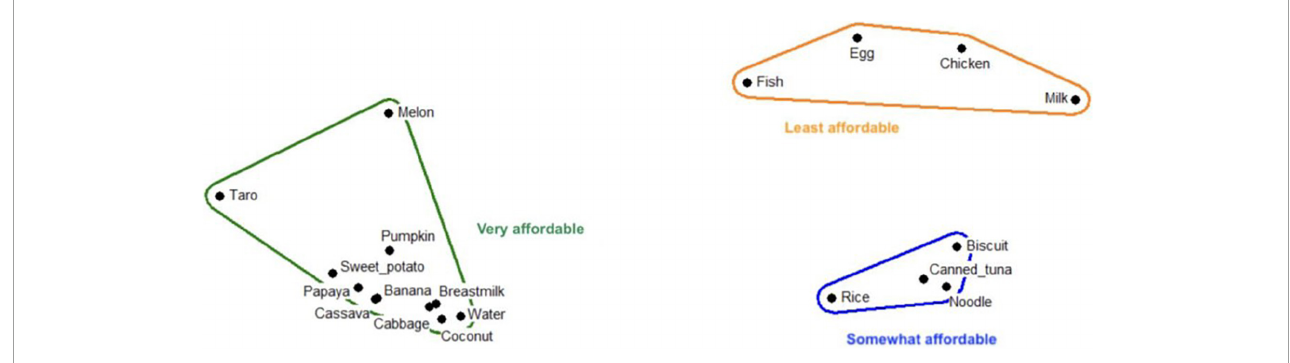
FIGURE3 Multi-dimensional scaling map depicting affordability of child foods in Malango (rural site); Stress: 0.042; Eigen value: 13.264; Eigen ratio: 3.025.